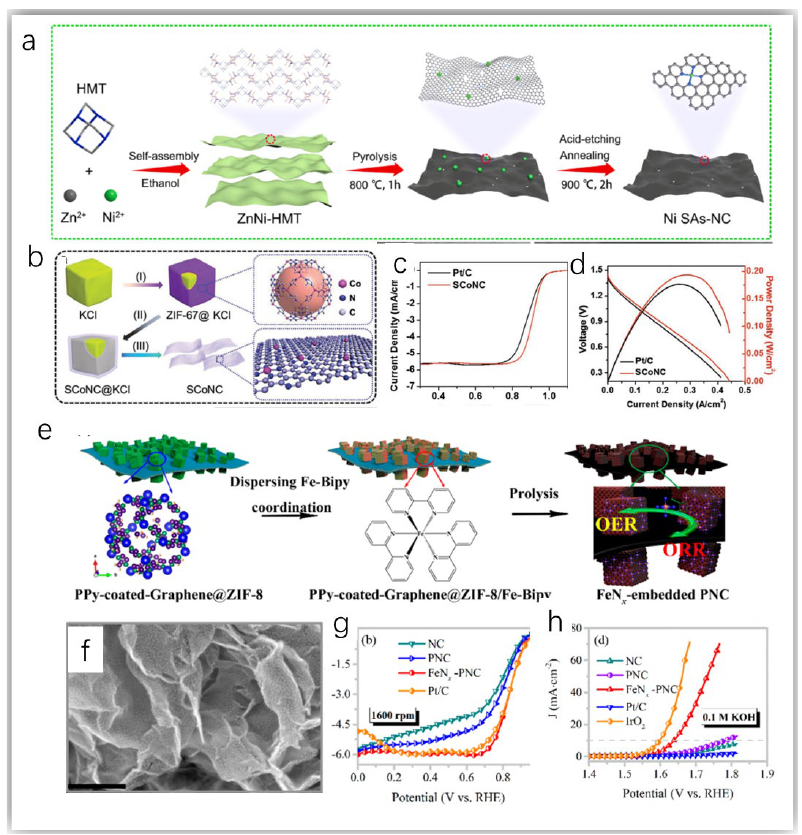
Figure 11. (a) Schematic illustration of the preparation process of Ni SAs-NC [98], reprinted with permission from Ref. [98]. Copyright © 2022 Elsevier B. V. (b) Schematic illustration of the prepara- tion process of SCoNC catalyst [99], (c) ORR activity of SCoNC catalyst [99], (d) Polarization and power density curves of primary ZABs using Pt/C and SCoNC as ORR catalyst [99], reprinted with permission from Ref. [99]. Copyright © 2019 Wiley-VCH Verlag GmbH & Co. KGaA, Weinheim. (e) Schematic illustration for synthesizing FeN x -PNC catalyst [100], (f) SEM image of FeN x -PNC catalyst